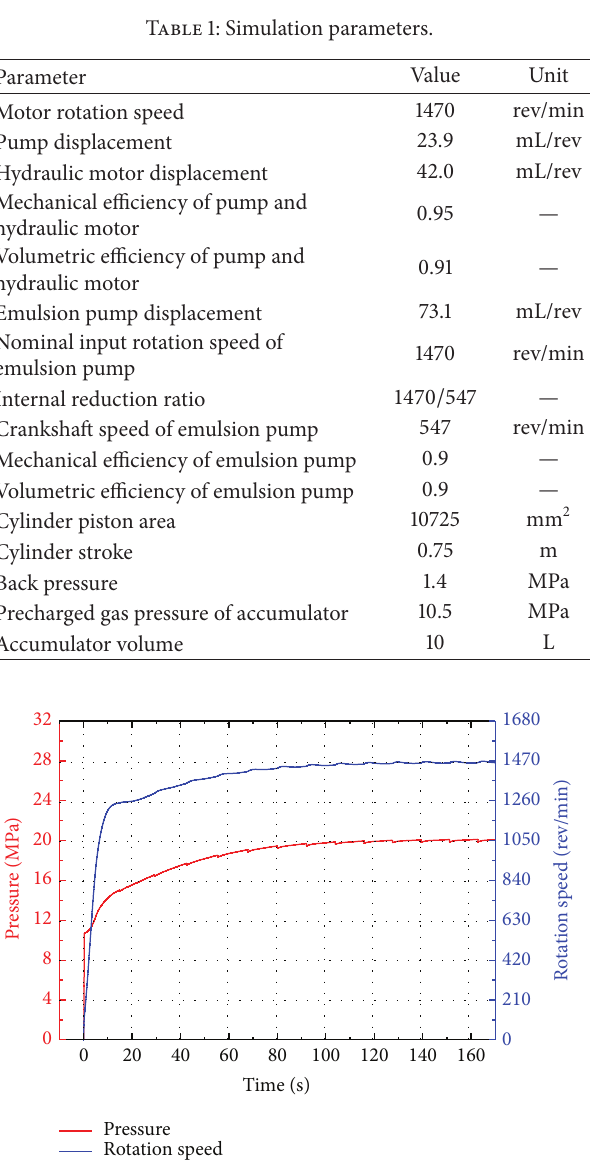
Figure 11: Simulation results of the test emulsion pump.